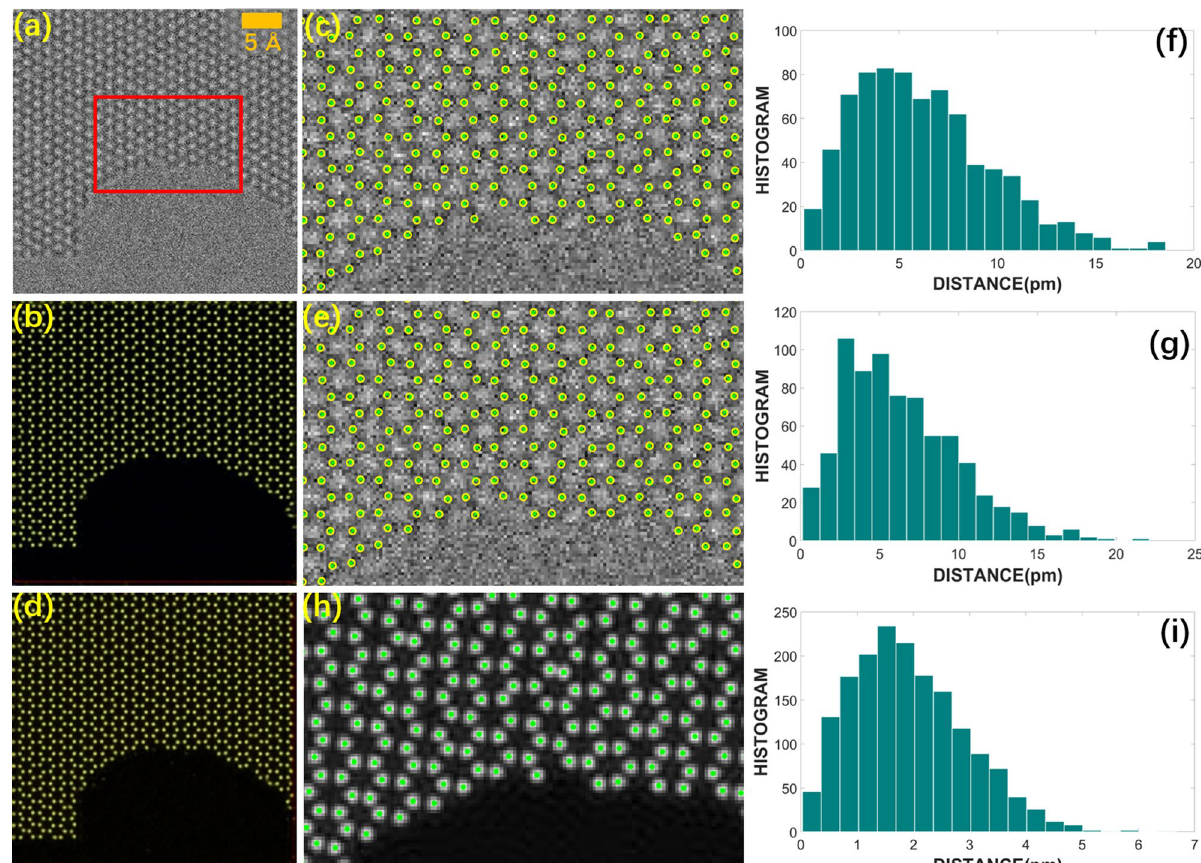
Figure 3. The precision of networks trained by different training sets. ( a ) A simulated image in the test set, and ( b ) its probability map predicted from the AP-GANs trained by the training set mixed with the simulated and experimental input–output image pairs. ( c ) A region extracted from ( a ), on which yellow circles are atom positions measured from ( b ). ( d ) The probability map predicted from the AP-GANs trained by the simulated training set. ( e ) A region extracted from ( a ), on which yellow circles are atom positions measured from ( d ). ( f , g ) Histogram of position errors between the true and those measured from the ( c ) and ( e ) image, respectively. And the errors are counted from approximately 800 positions. ( h ) Atoms are measured directly from the phase of the simulated wave of ( a ) with the assistance of CalAtom software. ( i ) Histogram of errors between the ground truth and those measured from ( h